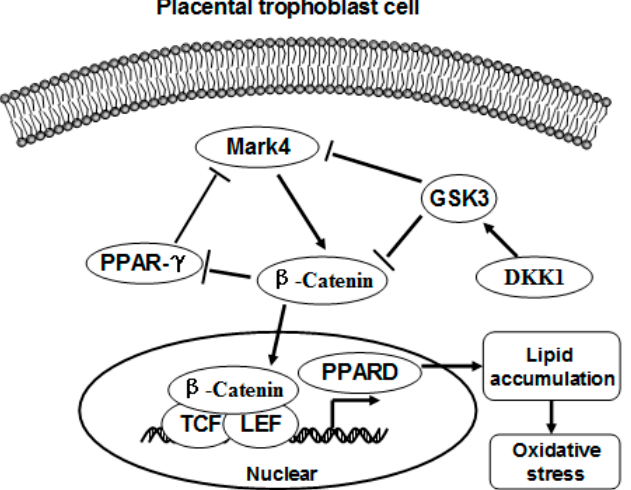
Figure 8. A proposed model for role of MARK4 in regulating lipogenesis in pig placental trophoblast cells. MARK4 promotes lipogenesis by activating WNT/ β -catenin signaling pathway. Arrows indicates a positive regulation and bar-headed lines show negative regulation. Interactions depicted are based on studies performed in various tissues (in some cases placenta) and have been previously published. Supplementary Materials: Supplementary Materials can be found at http://www.mdpi.com/1422-0067/20/5/ 1206/s1, Figure S1: The full-length cDNA of MARK4 gene in porcine and the deduced amino acid sequence, Figure S2: Clustal W alignment of the MARK4 protein from pig and other organisms, Figure S3: The secondary structure of the MARK4 protein in porcine constructed by the SABLE program, Figure S4: Phylogenetic tree based on MARK4 sequences made by MEGA 7.0 software using the neighbor-joining method, Figure S5: Identification of optimal fatty acid (FA) concentration for induction of FA accumulation in pig primary cytotrophoblasts, Table S1: Primer sets used for real-time PCR.